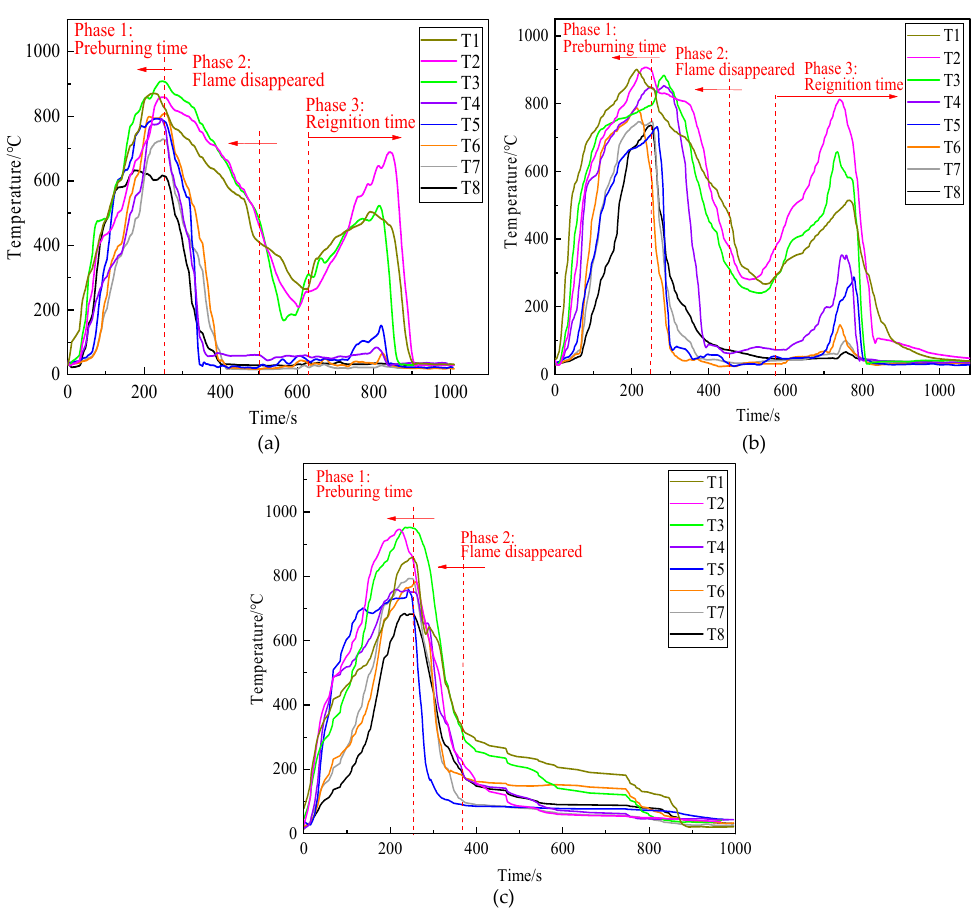
Figure 10. Flame temperature curves of: ( a ) ordinary gel extinguishing agent, ( b ) foam extinguishing agent, ( c ) 6 wt% thermosensitive hydrogel.